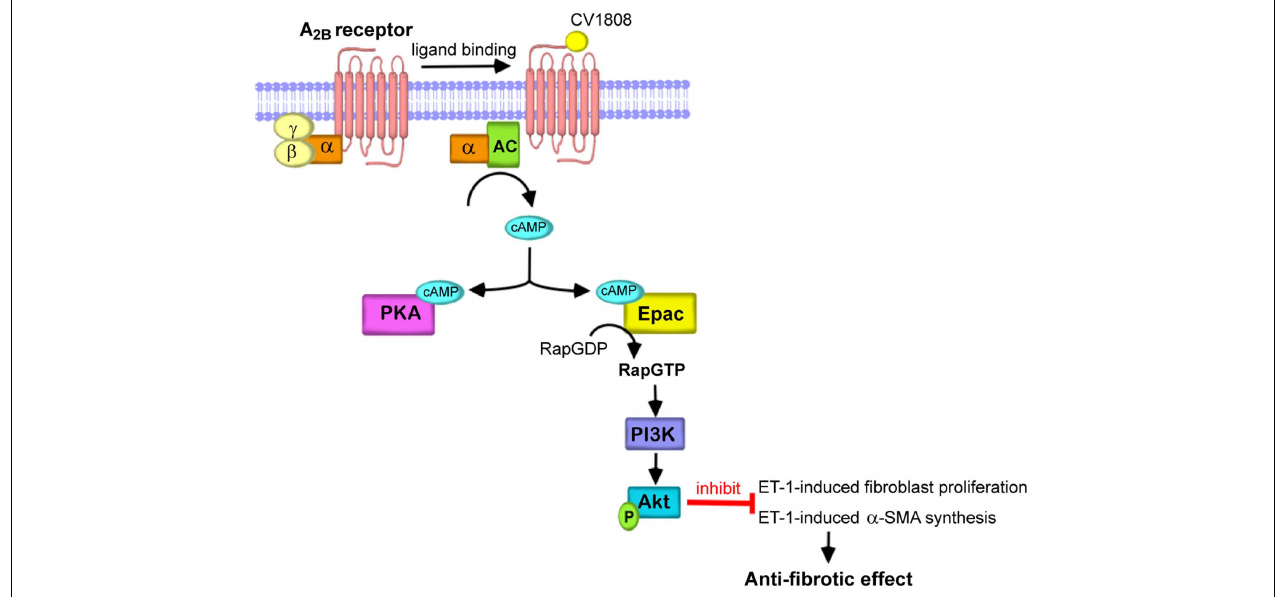
FIGURE 7 | Schematic diagram representing the essential role of Epac/PI3K/Akt for A 2B receptor-mediated antifibrotic effects. In cardiac fibroblast, agonist binding to the A 2B receptor leads to G protein coupling and activation of AC through G α s proteins increases the cAMP levels. cAMP directly binds to and activates Epac and subsequently stimulates Epac/PI3K/Akt signaling, which in turn inhibits cell proliferation and α -SMA production induced by ET-1. Therefore, stimulation of A 2B receptor elicits the antifibrotic effects in the